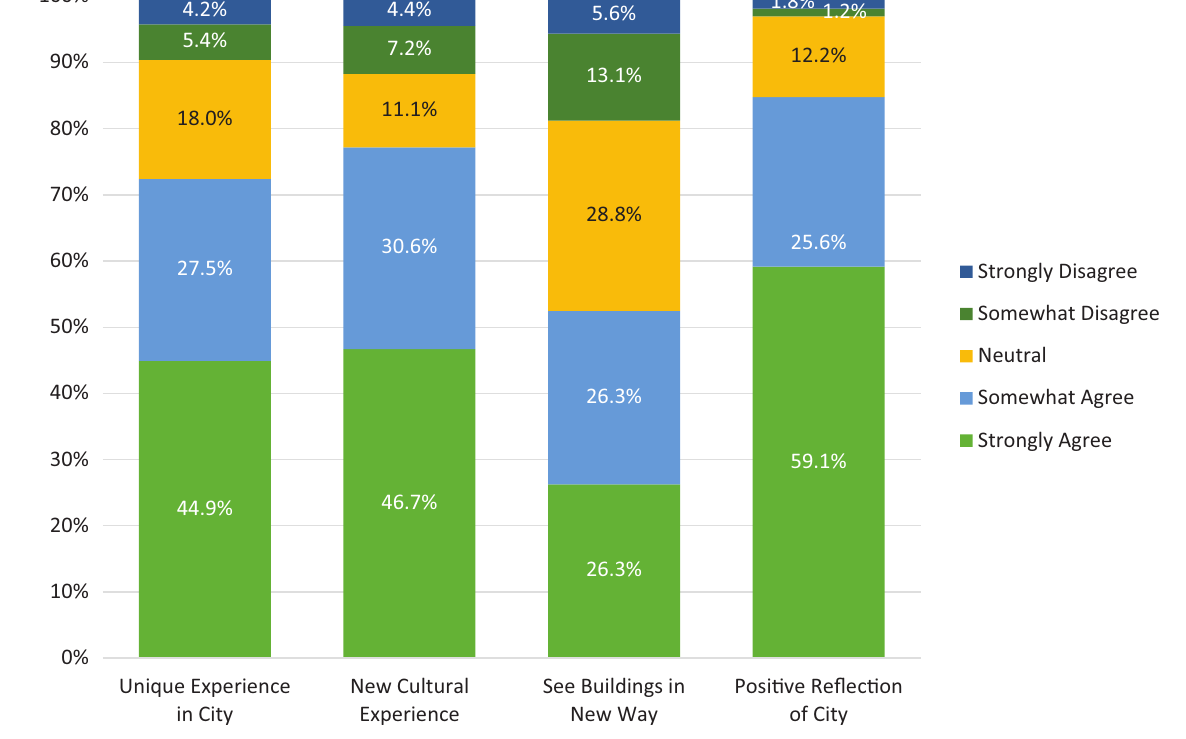
Figure 2. Festival participant experience